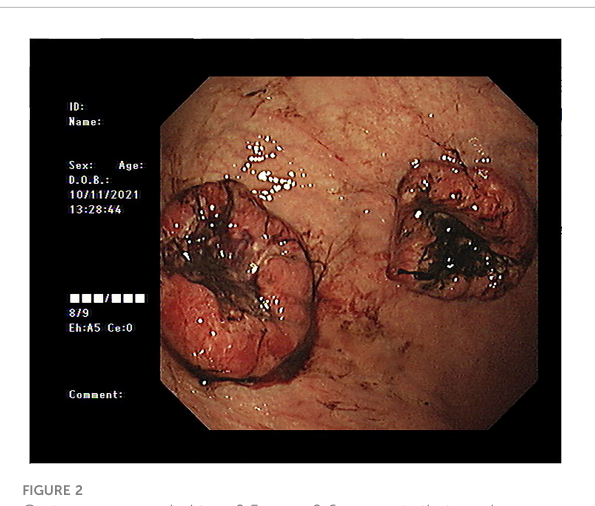
FIGURE 1 The visible size of the black tumor on the left plantar was approximately 2 × 1 cm.